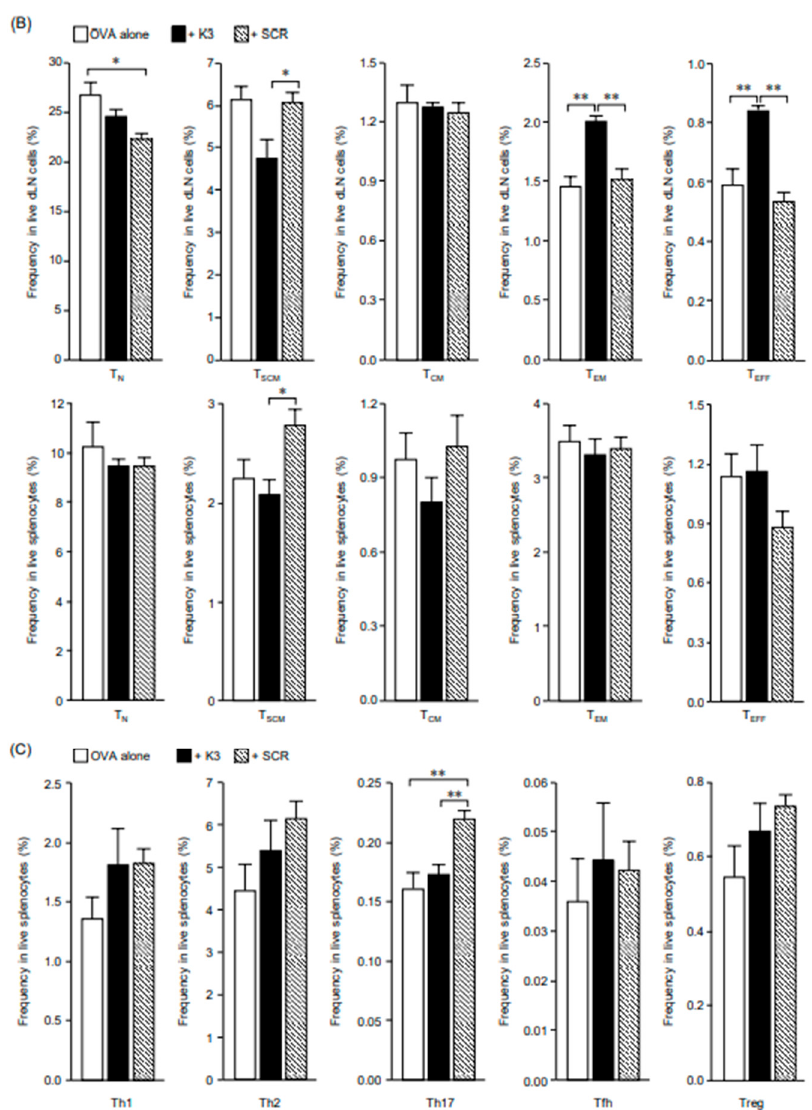
Figure 4. B ‐ and T ‐ cell differentiation after multiple immunizations with K3. C57BL/6 mice were immunized using the ovalbumin self ‐ dissolving microneedle patch (OVA ‐ sdMN) and K3 ‐ loaded hydrophilic gel patch (HG) methods with OVA, OVA + K3, or OVA + scramble (SCR) three times every two weeks. ( A ) Two weeks after the last immunization, B cells in the draining lymph nodes (dLNs) and spleen were divided into three subsets: germinal center (GC) B cells (B220 + , GL7 + , IgG1 + , CD95 + ), memory B cells (B220 + , GL7 − , IgG1 + , CD38 + ), and plasma cells (B220 − , CD138 + , IgD − ), and the frequency of each population was analyzed by flow cytometry. Data are expressed as the mean ± SE of results from 3–5 mice. ( B ) Two weeks after the last immunization, CD4 + T cells in the dLNs and spleen were divided into five subsets according to the stage of differentiation: T N (CD44 low , CD122 − ), T SCM (CD44 low , CD122 + ), T CM (CD44 high , CD127 + , CD62L high ), T EM (CD44 high , CD127 + , CD62L low ), and T EFF (CD44 high , CD127 − , CD62L low ) cells; the frequency of each population was analyzed using flow cytometry. Data are expressed as mean ± SE of results from three ‐ five mice (Tukey ‐ Kramer method, * p < 0.05, ** p < 0.01). ( C ) Two weeks after the last immunization, Ki ‐ 67 + CD4 + T cells in the spleen were divided into five subsets according to effector function: Th1 (T ‐ bet + ), Th2 (GATA3 + ), Th17 (ROR γ t + ), Tfh (CXCR5 + , Bcl ‐ 6 + ), and Treg (CD25 + , Foxp3 + ) cells; the frequency of each population was analyzed using flow cytometry. Data are expressed as mean ± SE of results from three ‐ five mice (Tukey ‐ Kramer method, ** p <